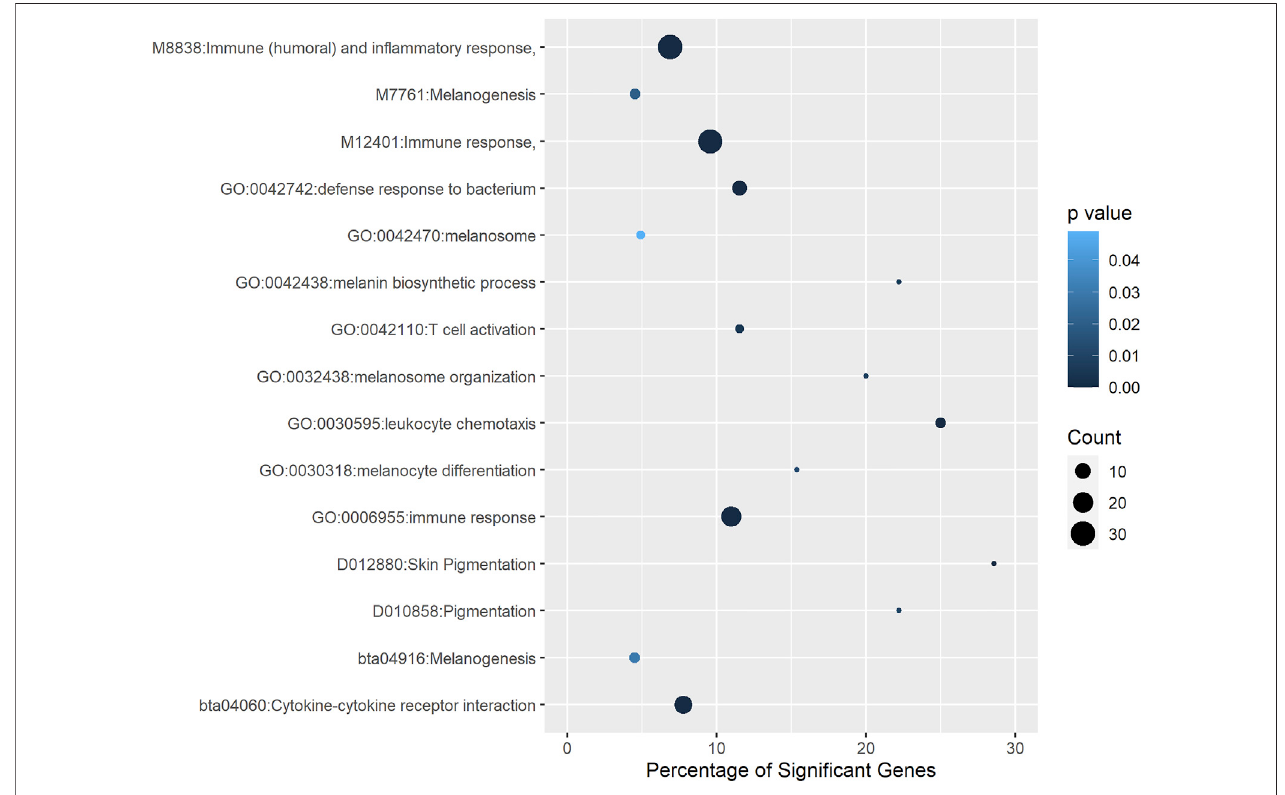
FIGURE 4 | Functional terms and pathways signi fi cantly enriched with genes associated with eyelid pigmentation. Different annotation databases, including GO, Medical Subject Headings, InterPro, Reactome and MSigDB, were used.